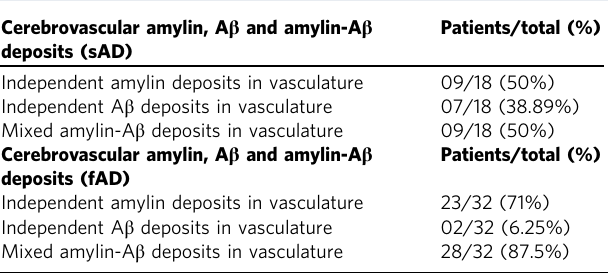
(Fig. 2c). As in human blood from persons with AD (Fig. 1f), interleukin (IL)-1 β maturation and pancreatic islet